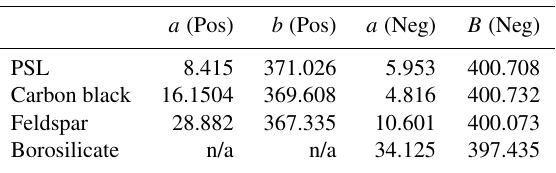
Table 6. Mass calibration coefficients calculated from the mode peak position (TOF) of three ion species for each samples in each ion mode. The ions species used are m/z + 24, + 36 + 48, − 24, − 60 and − 72 in PSL and carbon black mass spectra and m/z + 27, + 39, + 44, − 16, − 60, and − 76 in K-feldspar mass spectra. Positive ion calibration of the borosilicate glass was not possible with the peaks selected. Calibration points are expressed in 2.5ns bin widths (n/a = not